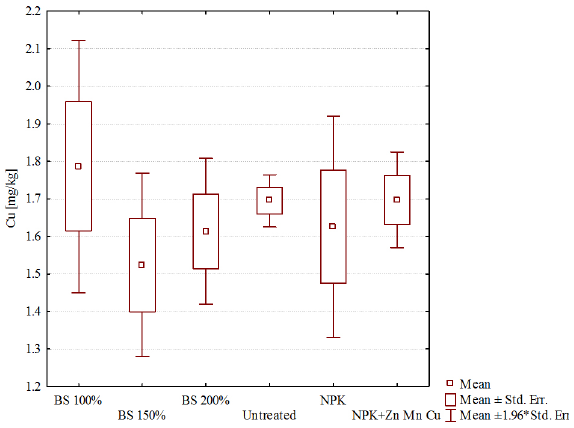
Figure 4: Copper content [mg kg -1 ] in grain vs. fertilizer.